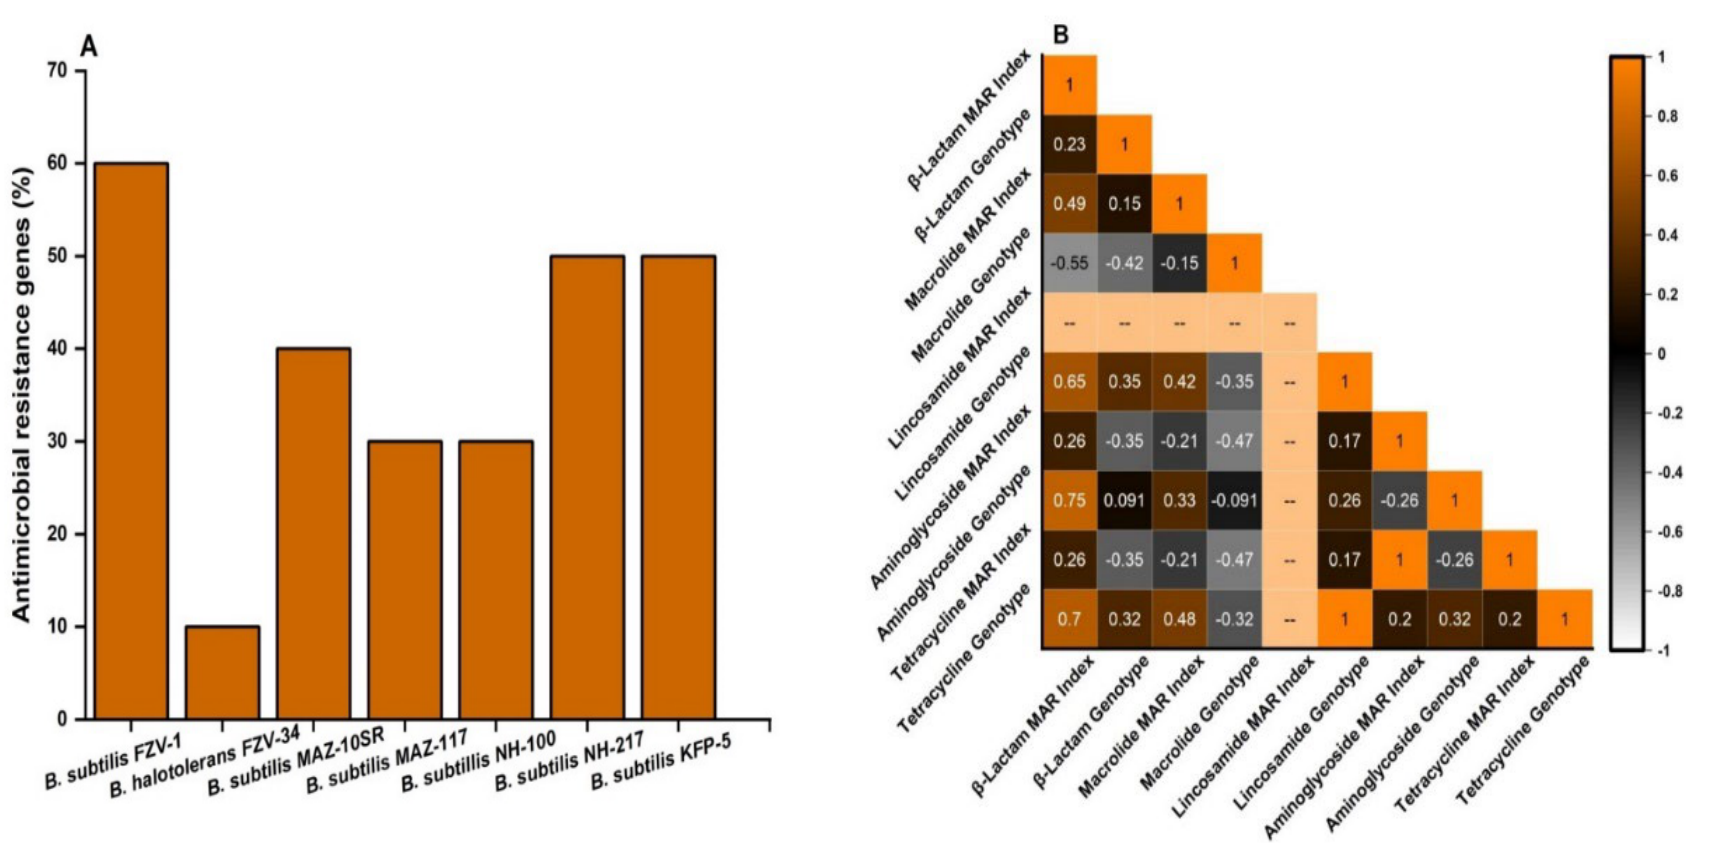
Figure 3. Presence of antibiotic-resistance genes in Bacillus spp. and correlation between resistant phenotype and genotype. ( A ) Frequency of antimicrobial resistance genes in Bacillus spp. ( B ) Phenotypic and genotypic correlation between antimicrobial resistance agents.